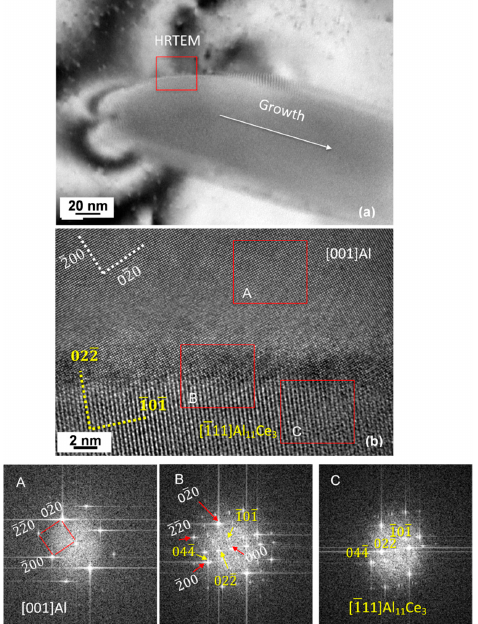
Figure 15. Structure of the Al 11 Ce 3 / Al interface within the eutectic during early stages of growth: ( a ) TEM bright field image with the marked growth direction; ( b ) HRTEM image of the area marked in ( a ) showing a change in coherency during growth of eutectic phases; FFT patterns from the regions marked in ( b ) for Al (A), Al 11 Ce 3 / Al interface (B) and Al 11 Ce 3 (C). The orientation relationship is close to [ 0 0 1 ]